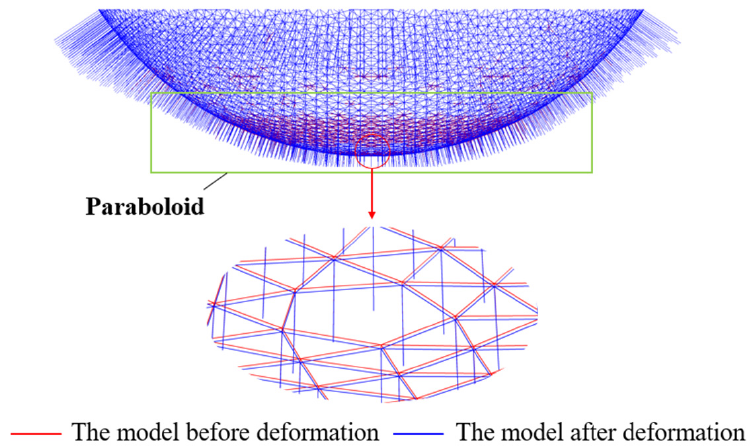
Figure 13. Comparison between two structures before and after deformation.